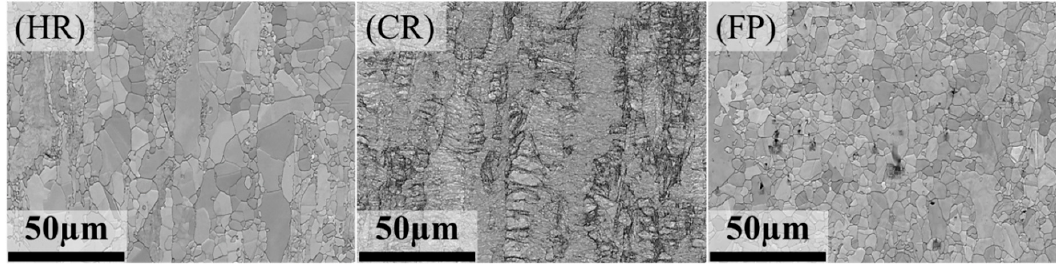
Figure 2. Image quality (IQ) of the different DSS samples studied.